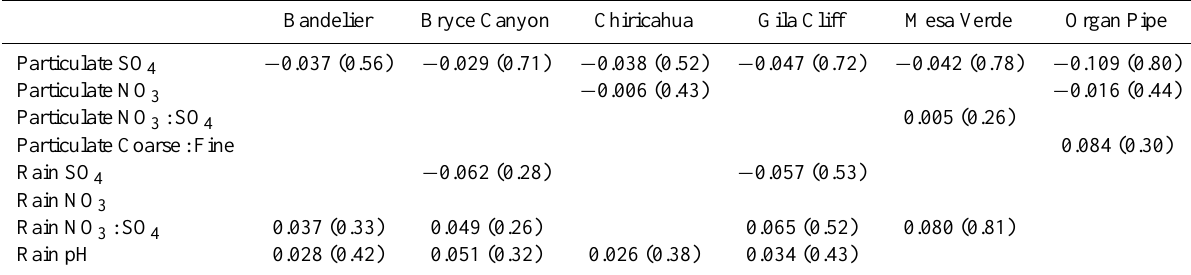
Table 4. Long-term trend analysis for the Southwest monsoon season (JAS). Slopes of each parameter versus year are shown with correlation coefficients ( r 2 ) of the linear best fit line in parenthesis. Units are µgm − 3 yr − 1 for the aerosol species, mgL − 1 yr − 1 for the rain species, and yr − 1 for the coarse:fine ratio, NO − :SO 2 − ratio, and pH. No other common aerosol and rain water species are shown as they do not have 3 4 statistically significant changes over the durations shown in Table